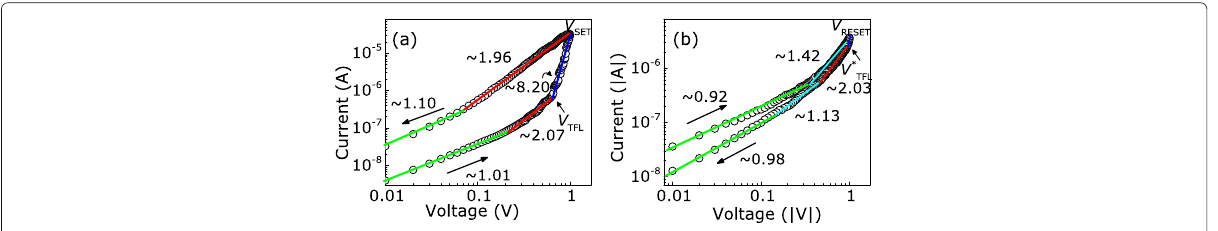
Fig. 5 The fitted lines of log I -log V plots in the a positive and b negative voltage regions. The arrows indicate the sweeping direction